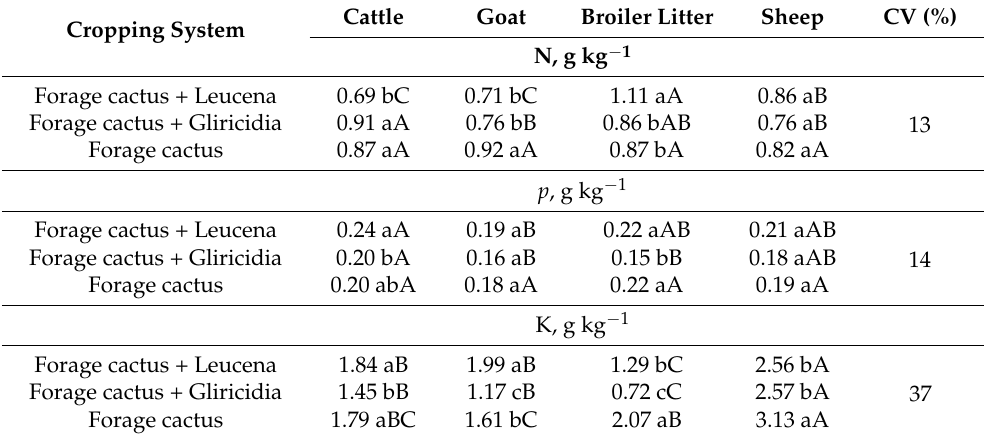
Table 8. N, p , and K concentration of forage cactus in different cropping systems and manure sources. Cattle Goat Broiler Litter Sheep CV (%) Cropping System N, g kg − 1 Forage cactus + Leucena 0.69 bC Forage cactus